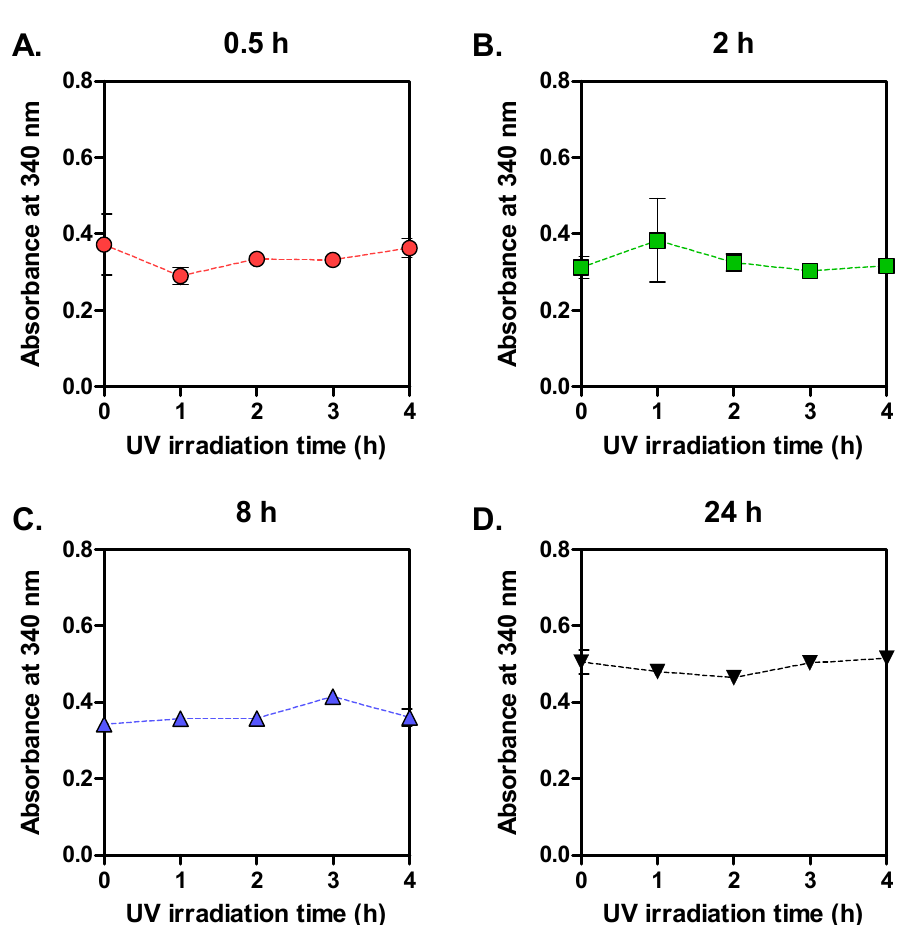
Figure 7. Absorbance at 340 nm obtained by 2,4,6-trinitrobenzene sulfonic acid (TNBS) assay with UV-irradiated SF films prepared with four SF solutions. The SFs were dissolved for different times ( A : 0.5 h; B : 2 h; C : 8 h; D : 24 h) (n = 3; mean ± SD).